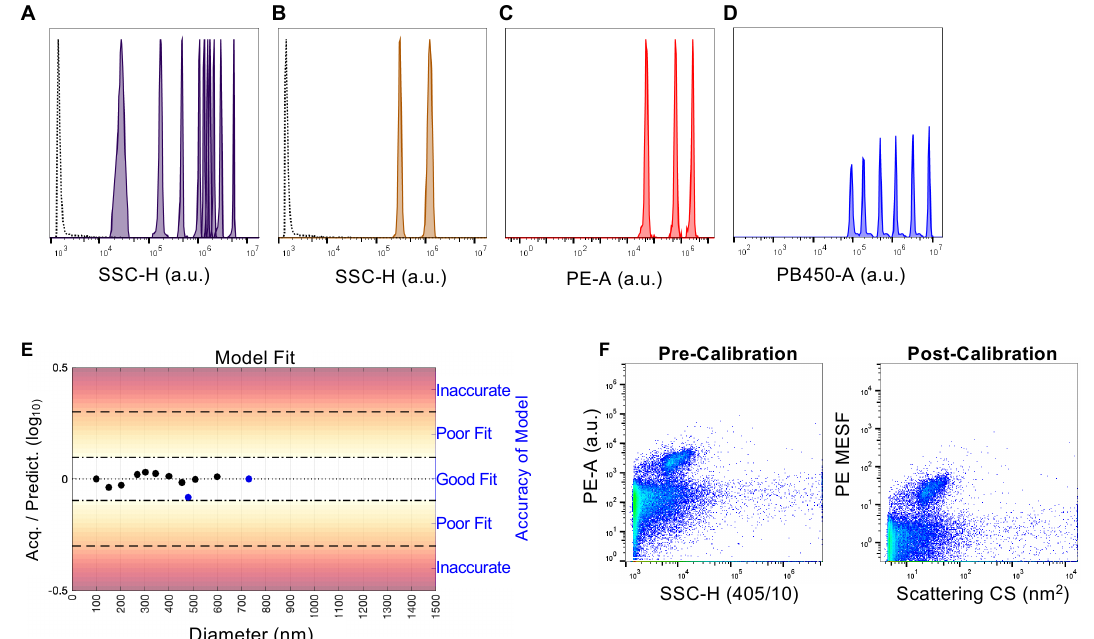
Figure 2. Standardization of flow virometry data with reference beads for light scatter and fluorescence Figure2. Standardizationofflowvirometrydatawithreferencebeadsforlightscatterandfluorescence, andcalibrationusingFCM PASS software. calibration using FCM PASS software. ( A ) NIST-traceable polystyrene (100, 152, 203, 269, 303, 345, 401, 453, 508, 600 nm) and ( B ) silica calibration beads (480, 730 nm) used to perform side scatter calibration. Bead populations are displayed from left to right in order of increasing diameter (i.e., higher arbitrary unit, a.u.). The empty dotted histogram denotes instrument background noise from PBS. ( C ) Quantibrite PE beads and ( D ) Rainbow calibration particles used for fluorescence calibration, as detected with the same gains used for virus sample acquisition on the flow cytometer. Bead populations are listed from left to right in order of increasing fluorescence (higher a.u.). ( E ) FCM PASS output assessing the fit of our data generated on the CytoFLEX cytometer for scatter modeling by comparing the predicted versus acquired scatter values for the sizing beads of di ff ering diameters (black and blue data points represent polystyrene and silica beads, respectively). ( F ) Representative plots comparing uncalibrated data expressed in arbitrary units of fluorescence intensity to calibrated data in standard units (MESF, nm 2 ), using CD14 + HIV stained with an anti-CD14-PE antibody as representative data.